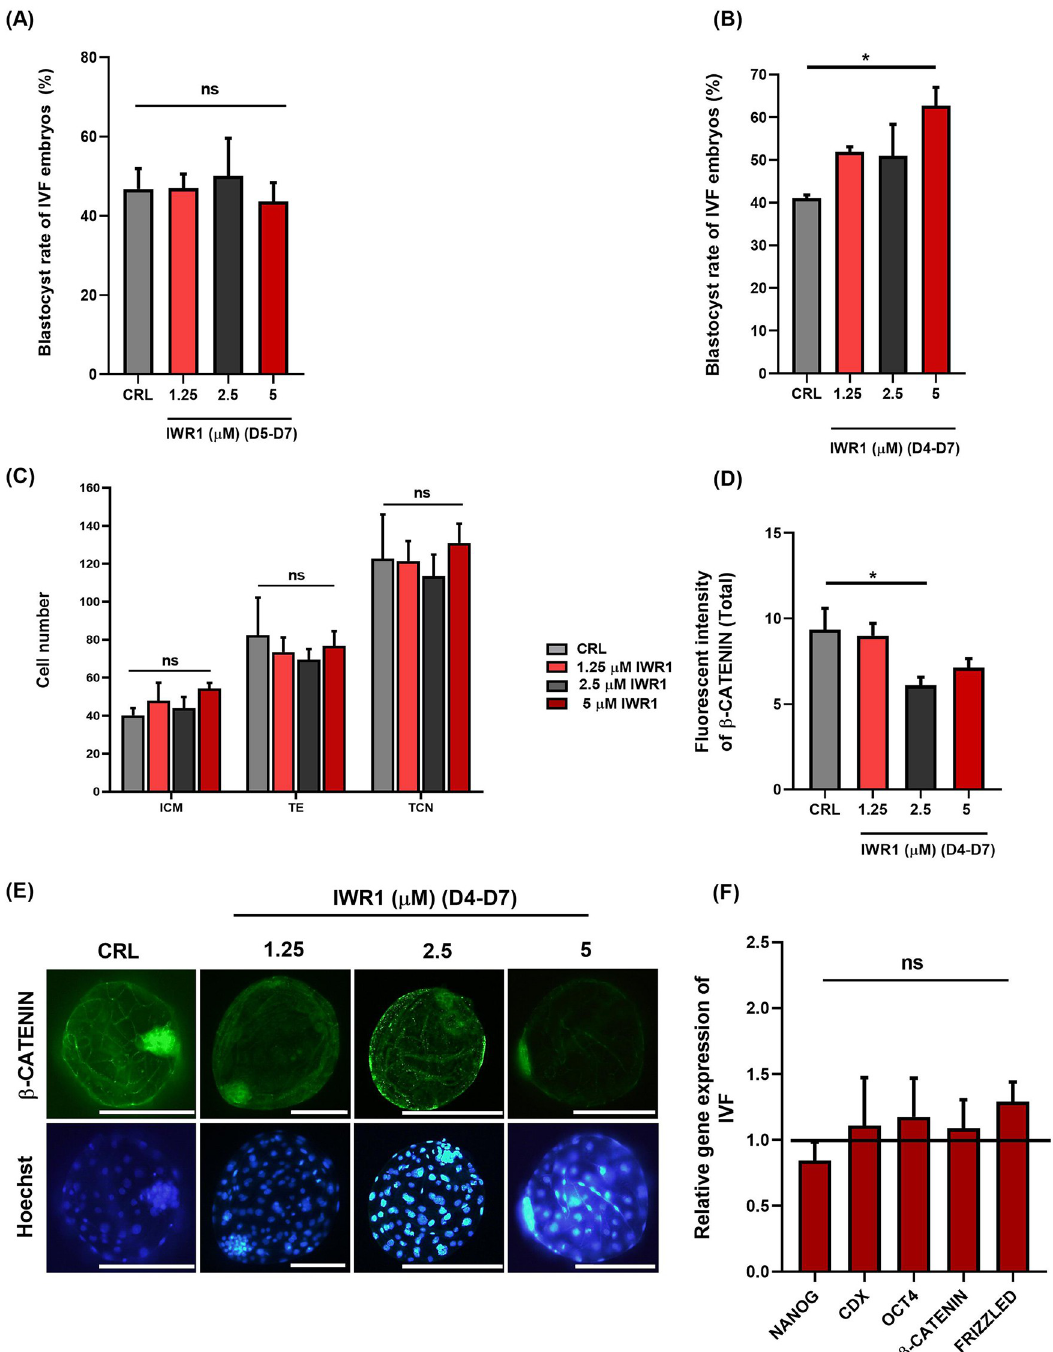
Fig 2. The effect of 1.25, 2.5 and 5 μ M IWR1 during in vitro culture (IVC) from (A) D5 to D7 and (B) D4 to D7 in goat IVF embryos on blastocyst rate (/cleaved embryos). (C) The effect of IWR1 treatment on blastomere allocation of IVF treated embryos. (D) The effect of IWR1 treatment during D4-D7 on fluorescent intensity of β -CATENIN in IVF embryos. (E) Representative immunofluorescence images of β -CATENIN in IVF embryos following treatment with IWR1 during D4-D7. (F) The effect of 5 μ M IWR1 during D4-D7 in goat IVF embryos on the relative expression of NANOG , CDX2 , OCT4 and β -CATENIN . Mean ± S.E.M. values are from at least three independent experiments ( * P < 0.05 and ns P > 0.05). Scale bars represent 200 μ m.